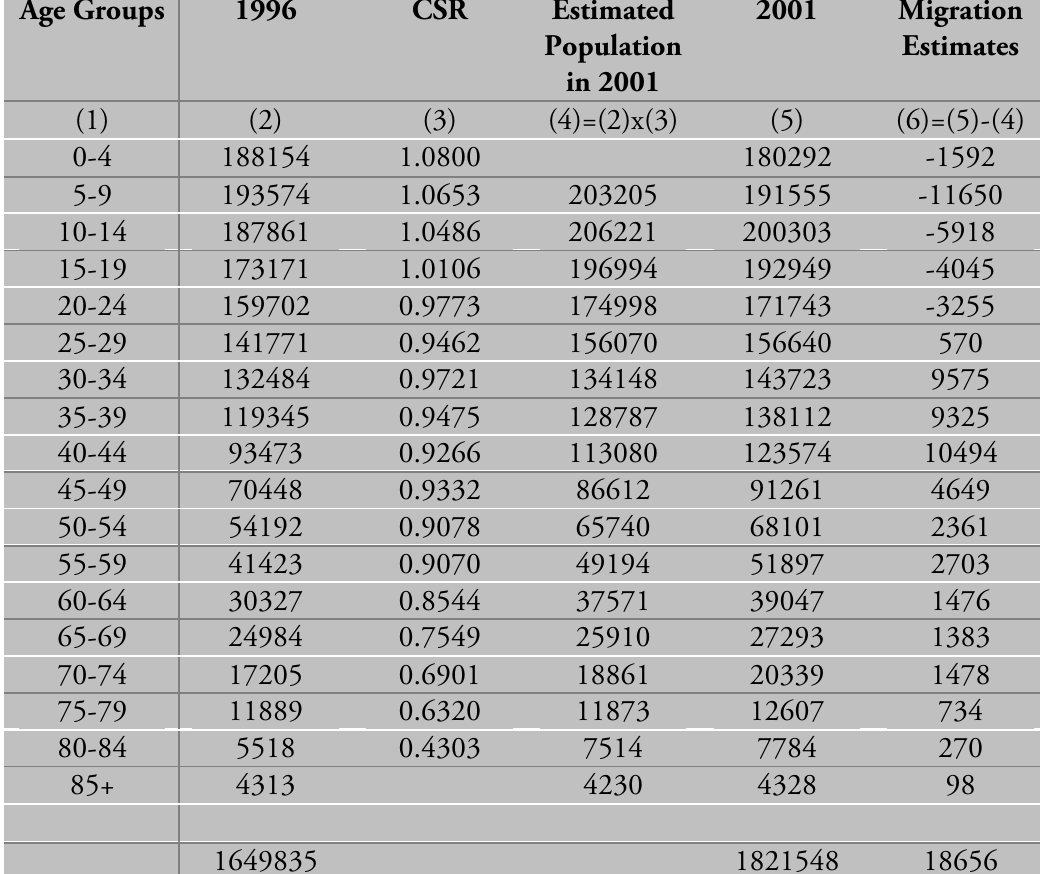
Table 2: Estimating Net Migration for North West Province using Census Survival Ratio Method, Male Age